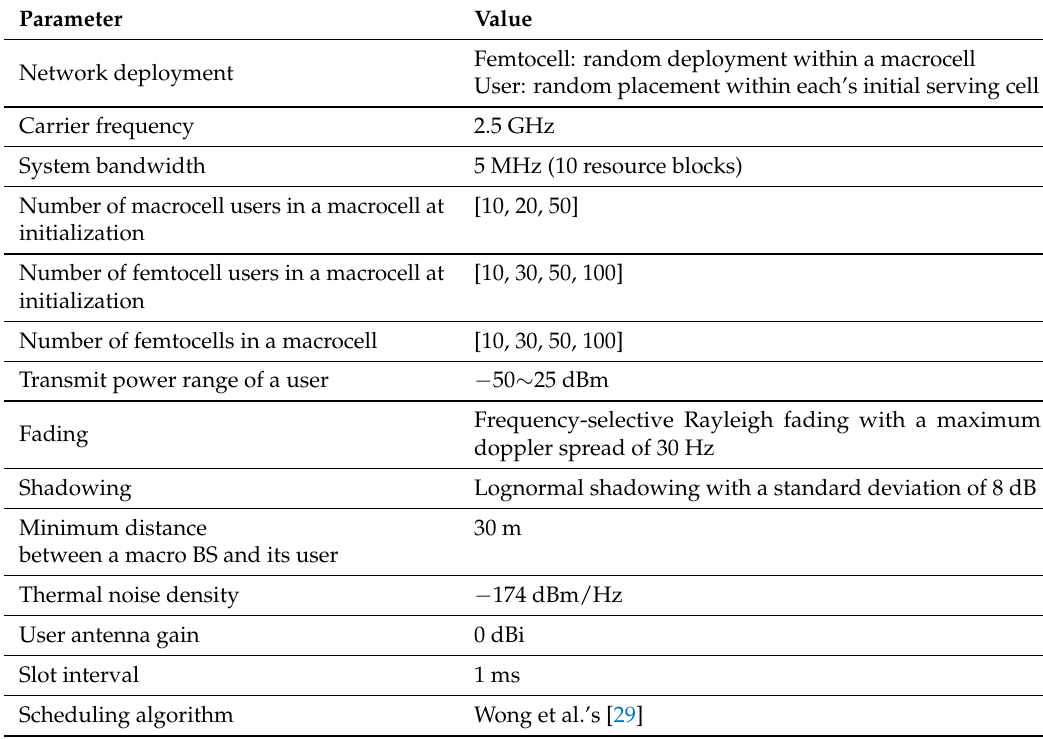
Table 1. Simulation